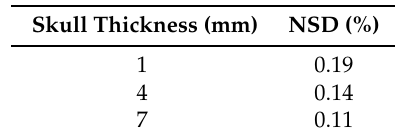
Table 2. Normalized standard deviation (NSD) errors between the k-Wave and the proposed method for the simulation of different skull thicknesses with constant target depth, d = 1.7 cm.